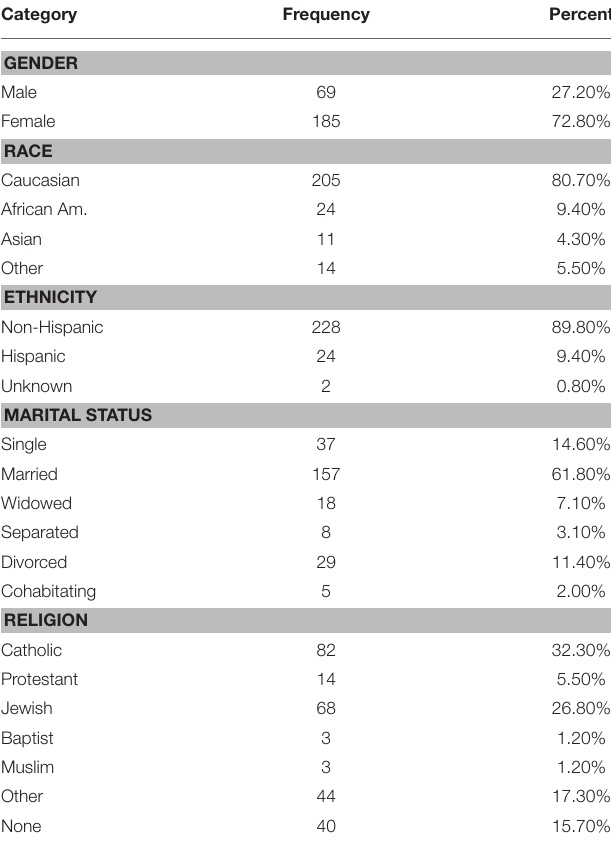
TABLE 1 | Descriptive statistics ( N =